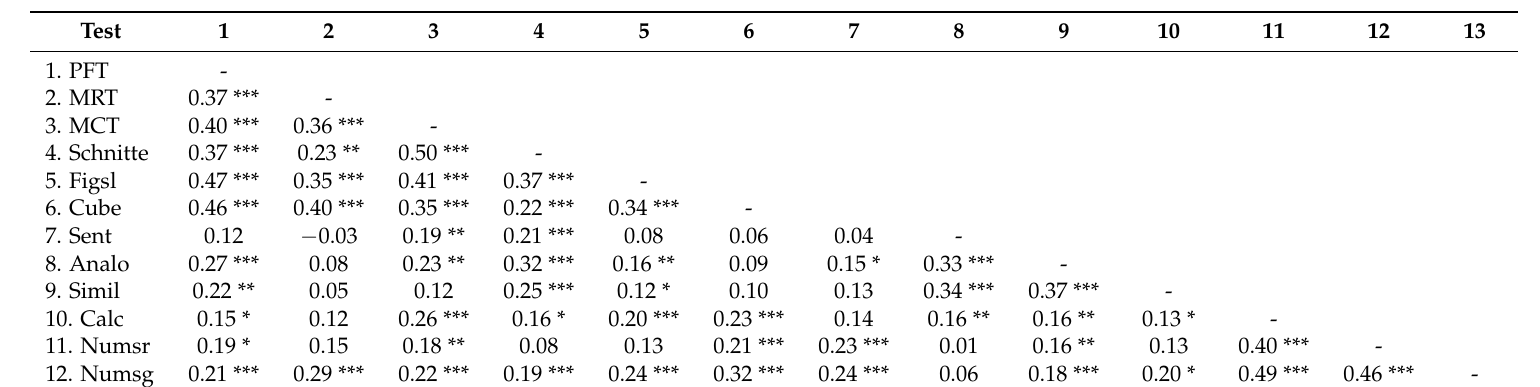
Table 4. Correlations between scores on ability tests ( N =